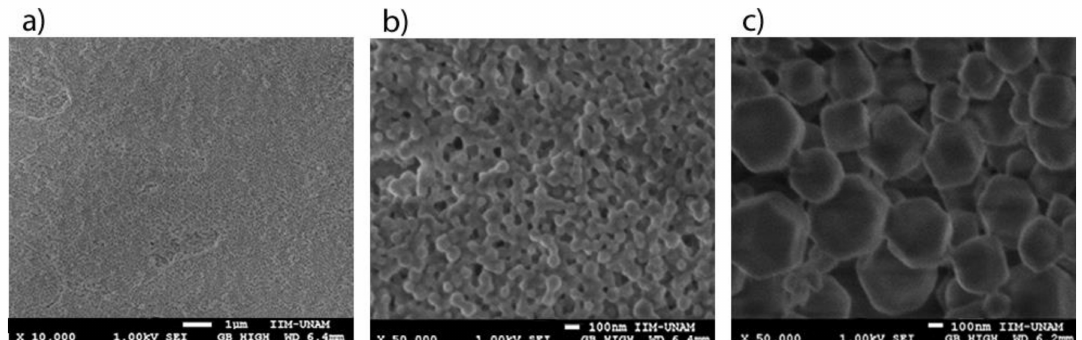
Figure 6. SEM image with magnification of ( a ) 10,000 × for a continuous layer of ZIF-8 nanocrystals, ( b ) 50,000 × for a layer of ZIF-8 nanocrystals and ( c ) 50,000 × for a layer of ZIF-67